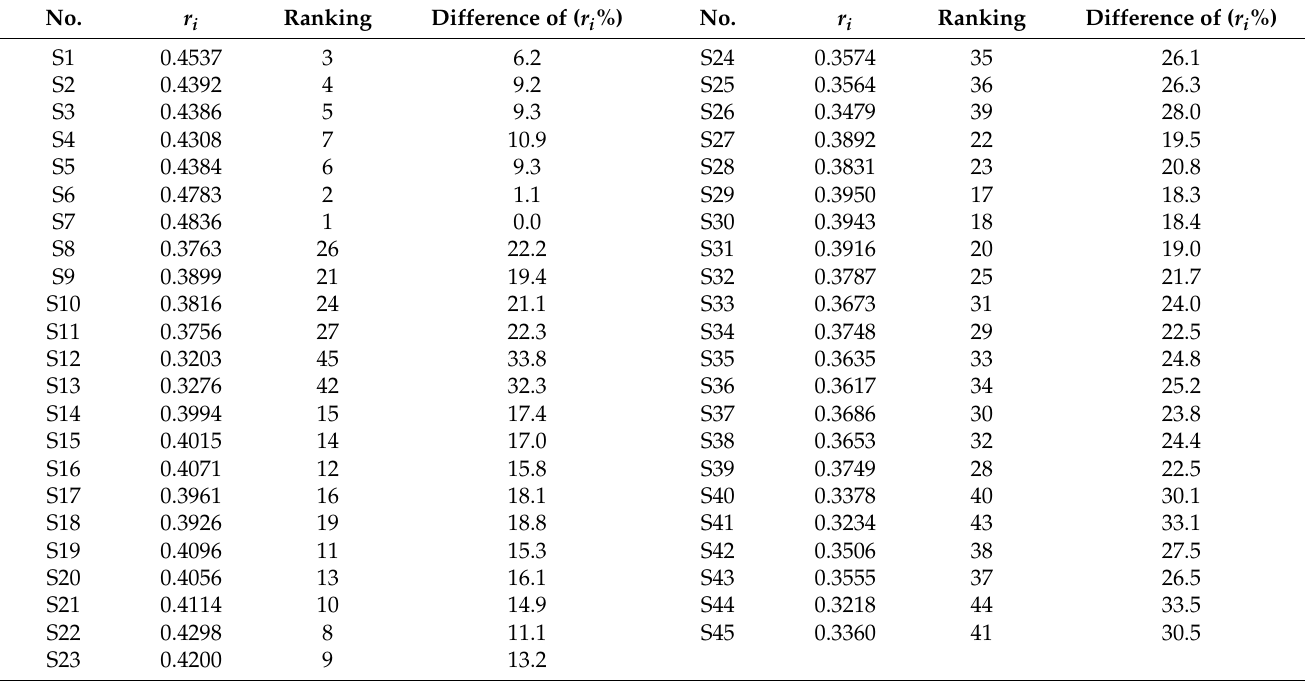
Table 4. Quality sequencing of the 45 tested